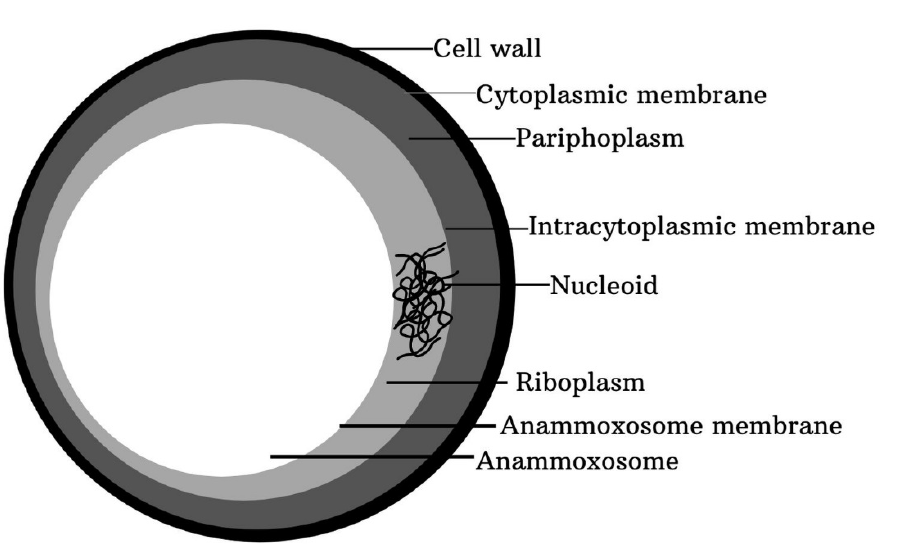
Figure 3. The Planctomycetes cell structure. Source: Authors’ original compilation.